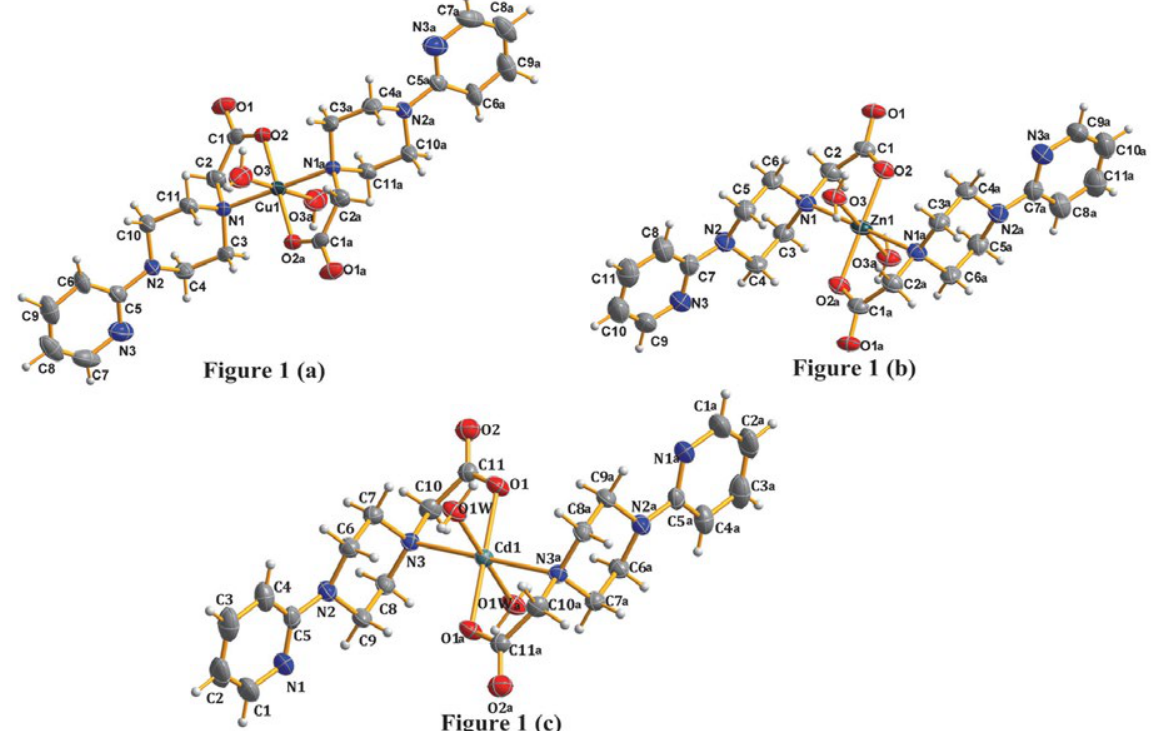
Figure 1. Molecular structure showing the atom-labelling scheme. Displacement spheres are drawn at the 50% probability level. The molecular dia- gram of (a) 1 , (b) 2 , (c) 3